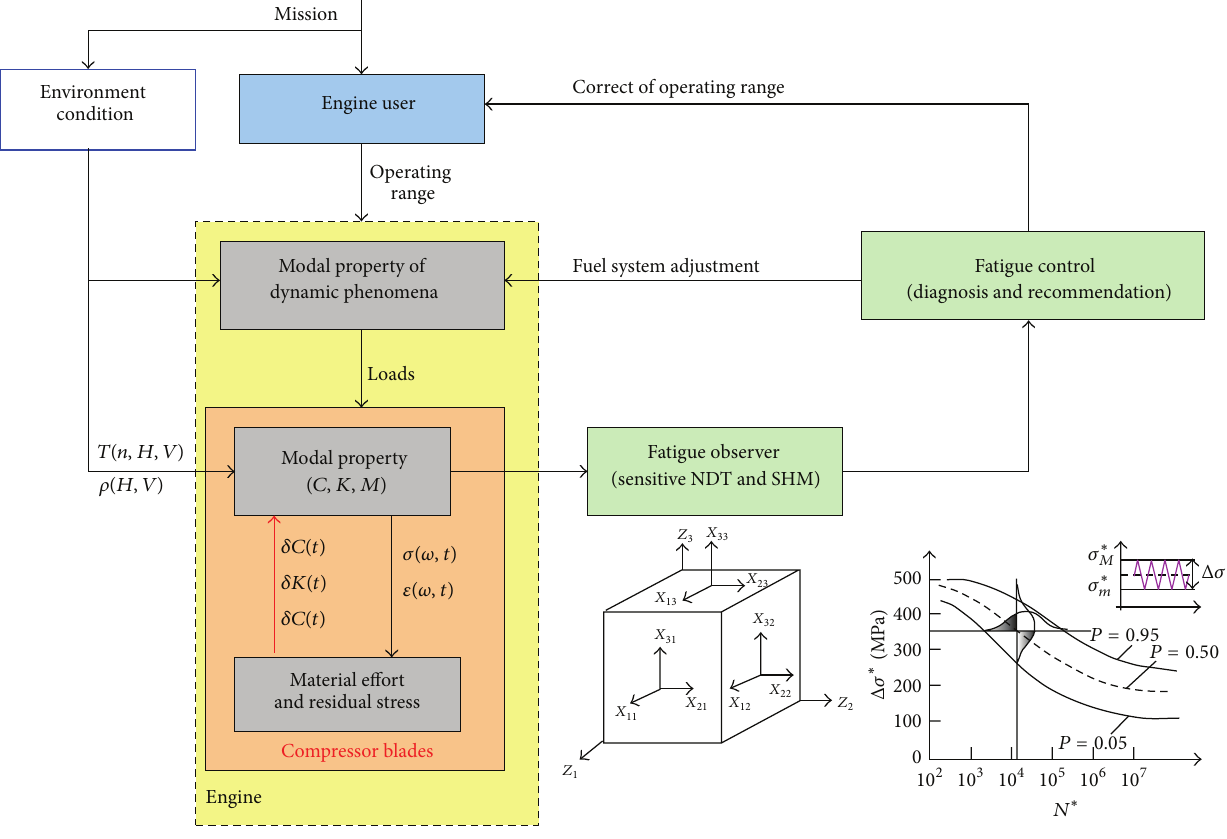
Figure 3: Idea of actively control fatigue by engine user—do not wait for blade crack